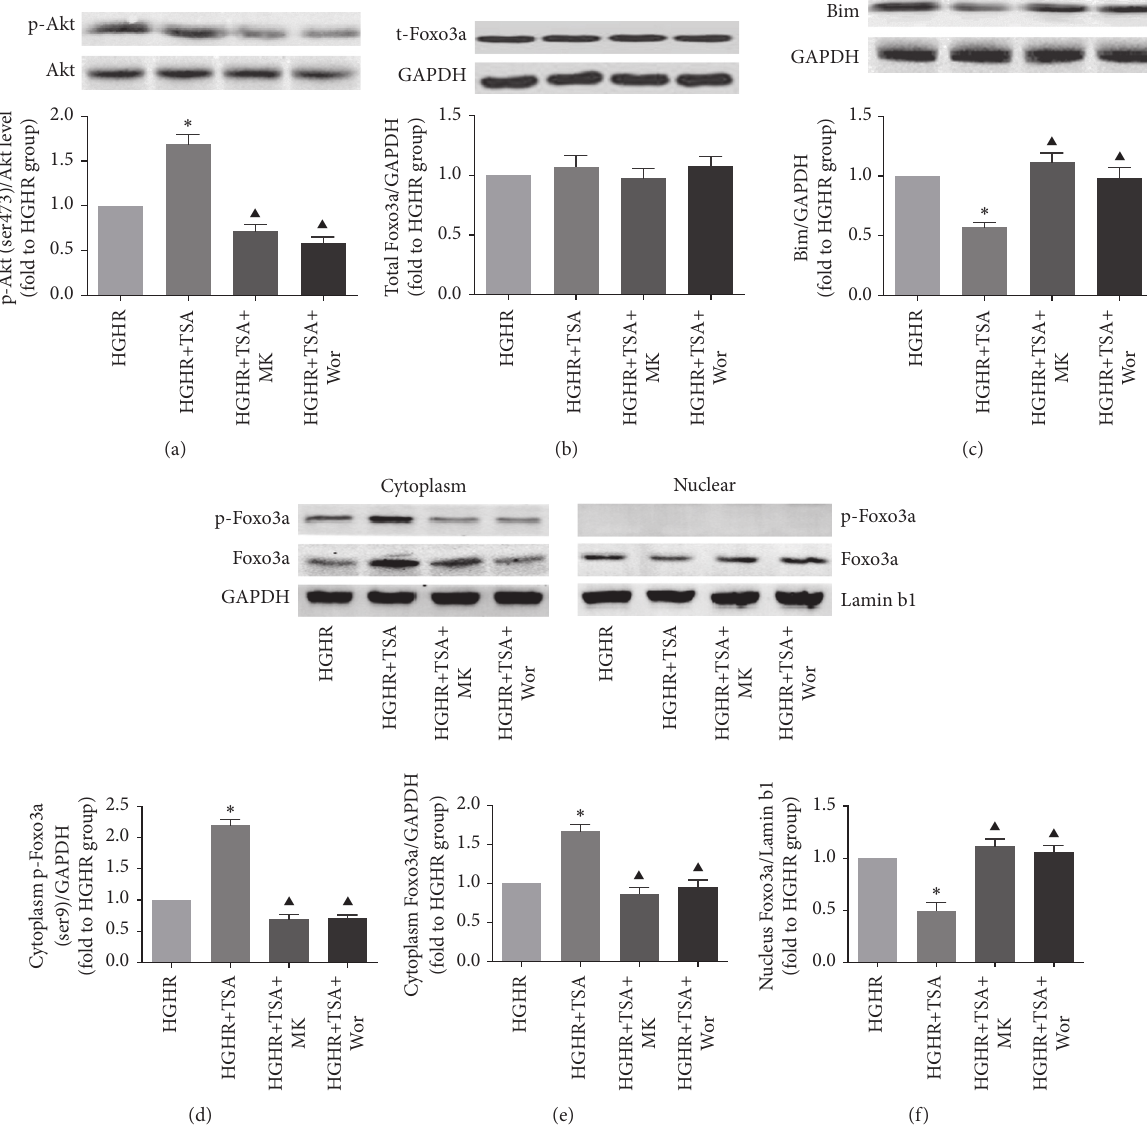
Figure 9: Expression of p-Akt/Akt, p-Foxo3a/Foxo3a, and Bim. Cardiomyocyte p-Akt, total-Akt (a), total-Foxo3a (b), Bim (c), cytoplasm p-Foxo3a (d), cytoplasm Foxo3a (e), and nuclear Foxo3a (f) Western blots images and protein levels analysis. GAPDH or Lamin b1 served as the loading control. ∗ 𝑝 < 0.05 versus HGHR group. 󳵳 𝑝 < 0.05 versus HGHR+TSA group.